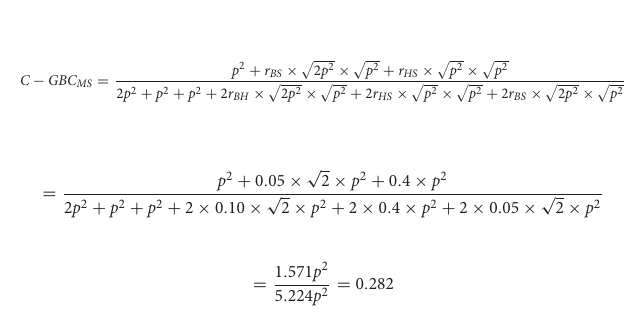
Correlation with Beefmaster